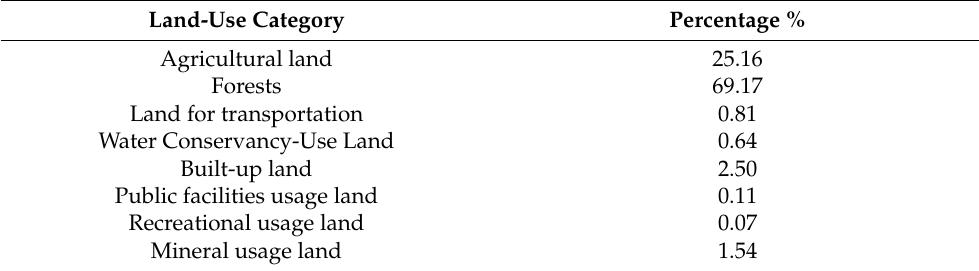
Table 2. The percentage of each land-use category of the Hen Chi basin.